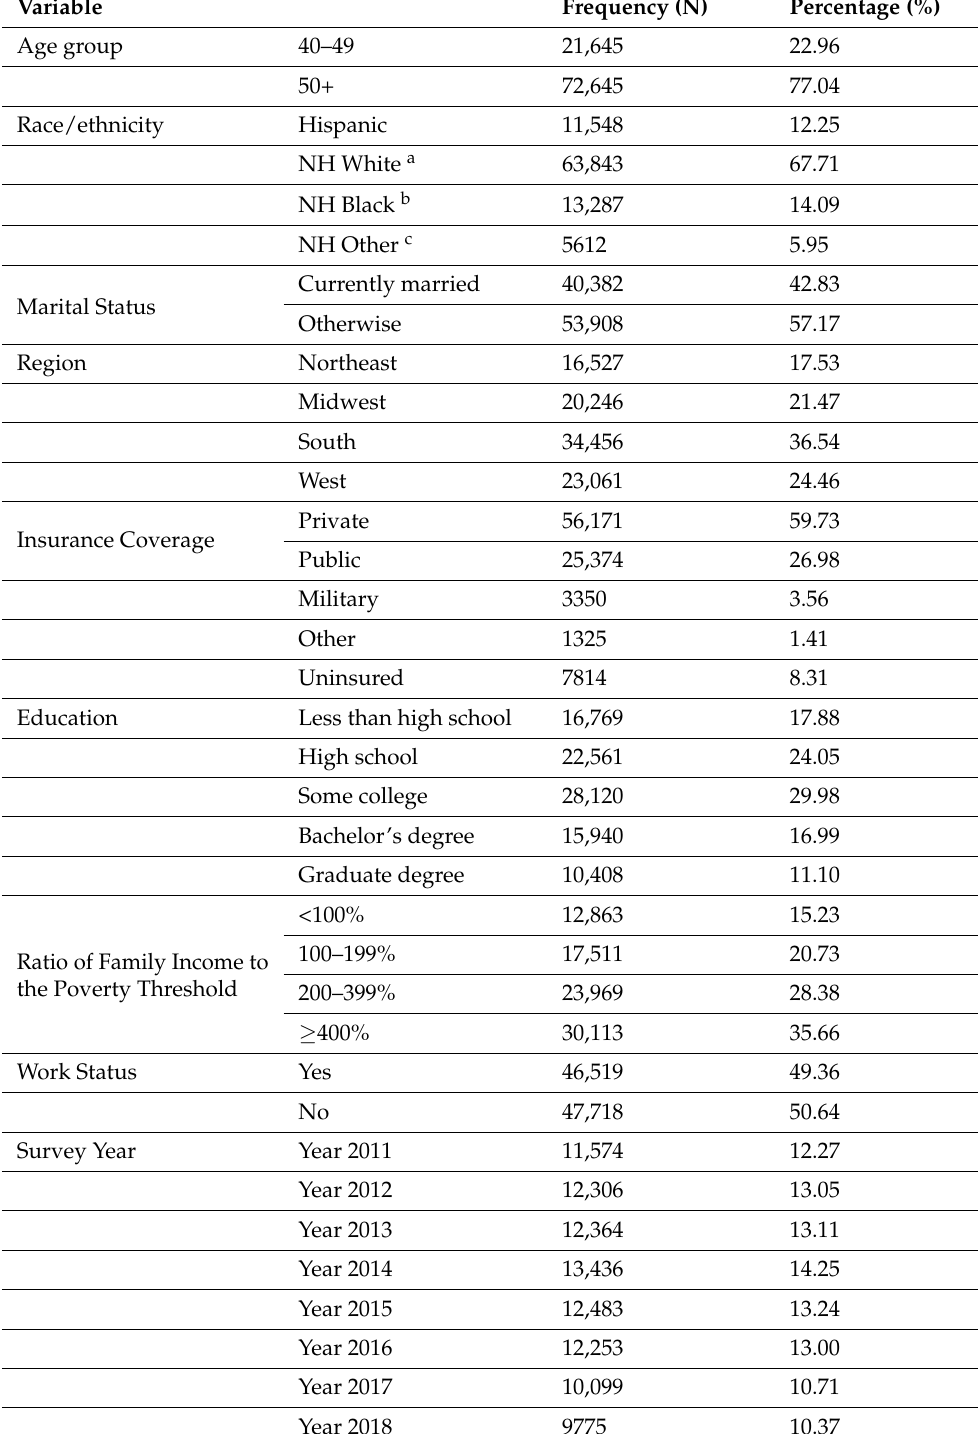
Table 1. Descriptive statistics of the demographics and socioeconomic characteristics among women aged 40+, 2011–2018 (n =